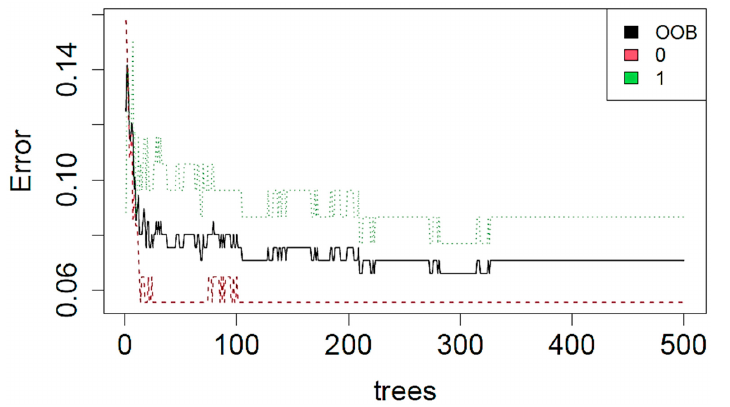
Figure 3. Error evolution during the training procedure of the RF method for the prediction of tumor nature from CC images.